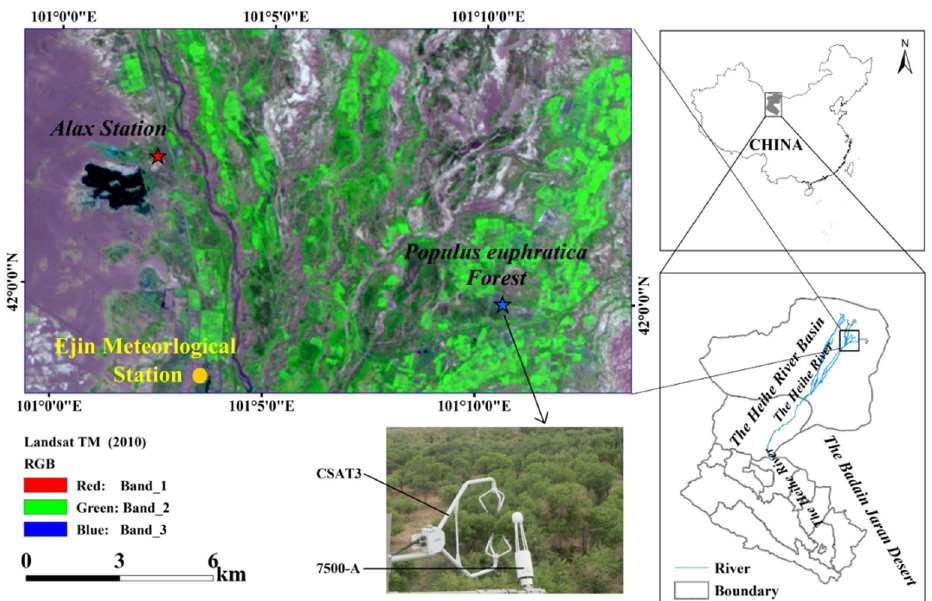
Figure 1. The schematic diagram of the Heihe River Basin (HRB), selected Populus euphratica stand and Ejin Meteorological Station, northwest China.